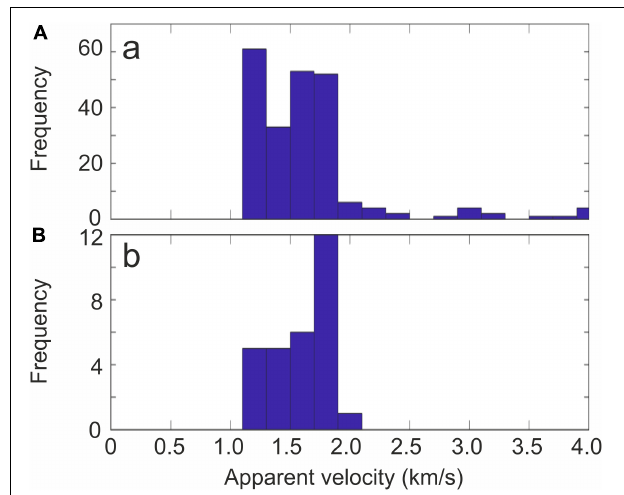
FIGURE 8 | Histograms showing the apparent velocity estimated by f – k analysis on 26/04/2011 (a) and on 18/12/2011 (b) .